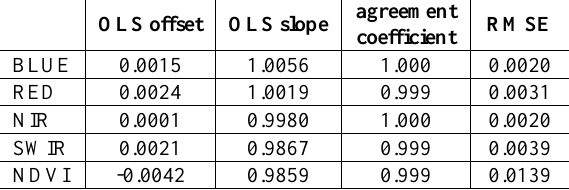
Table 4. TOC spectral correction functions between PROBA-V and